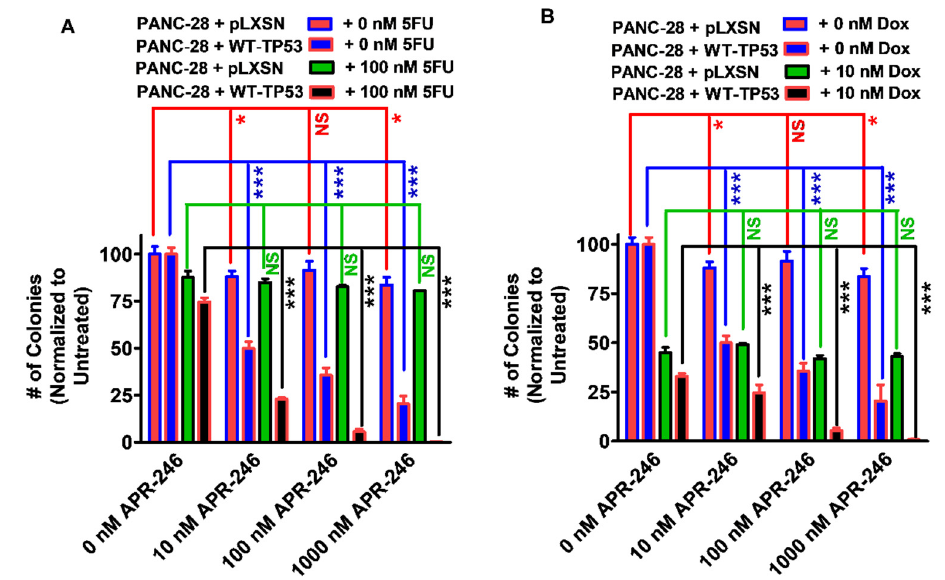
Figure 9. Effects of APR-246 on clonogenicity of PANC-28 + pLXSN and PANC-28 + WT-TP53 cells in the presence and absence low doses of 5FU or doxorubicin. The effects of ABR-246 on clonogenicity in the presence of low doses of 5FU (Panel ( A )) or doxorubicin (Panel B) were examined, with PANC-28 + pLXSN in the absence of APR-246 (solid red bars), PANC-28 + WT-TP53 in the absence of APR-246 (solid blue bars), PANC-28 + pLXSN in the presence of APR-246 and 5FU (Panel ( A )) or doxorubicin (Panel ( B )) (solid green bars), PANC-28 + WT-TP53 in the presence of APR-246 with either 5FU (Panel ( A )) or doxorubicin (Panel ( B )) (solid black bars). In each condition, the cells were plated in 3 wells of a 6–well plate, and cells in each panel were all examined at the same time period. *** = p <0.0001, * p < 0.05, and NS = not statistically significant.